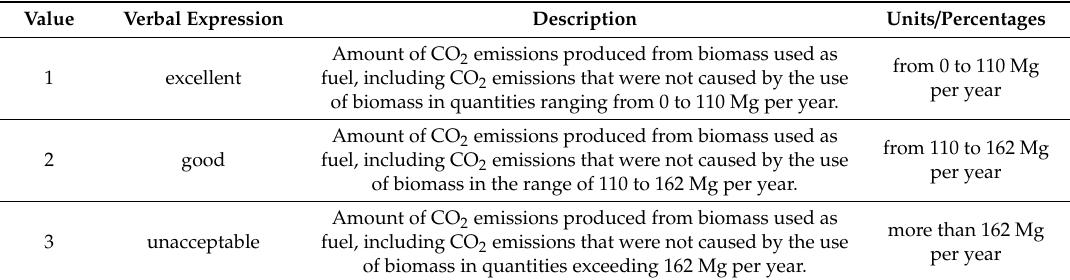
Table 2. Indicator—Amount of carbon dioxide (CO 2 ) released into the